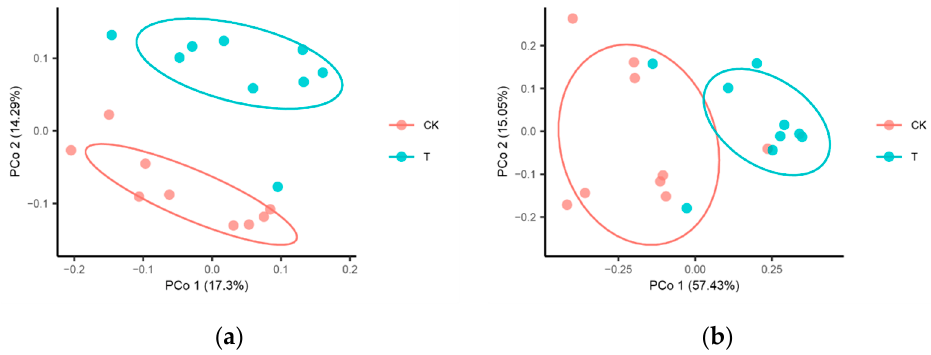
Figure 2. Principal coordinate analysis (PCoA) of bacterial ( a ) and fungal ( b ) beta diversity based on the Bray–Curtis distance between all rhizosphere soil samples inoculated with Streptomyces (T) and without Streptomyces inoculation (CK).